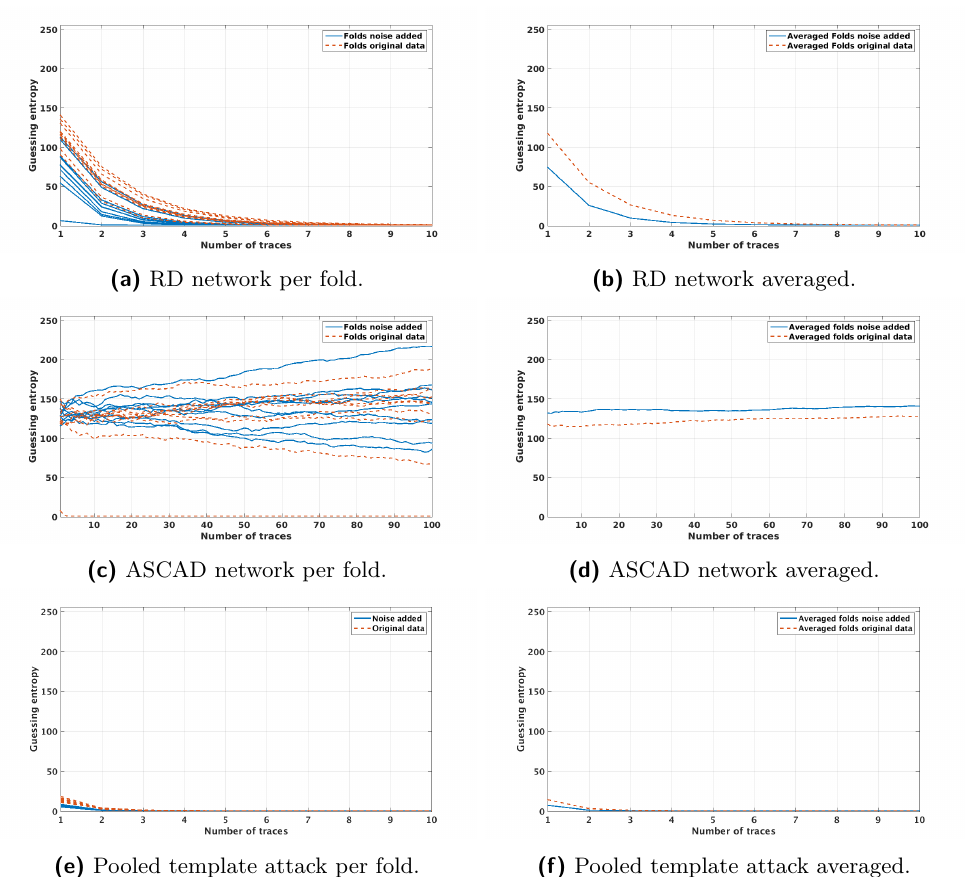
Figure 3: Guessing entropy results for the DPAcontest v4